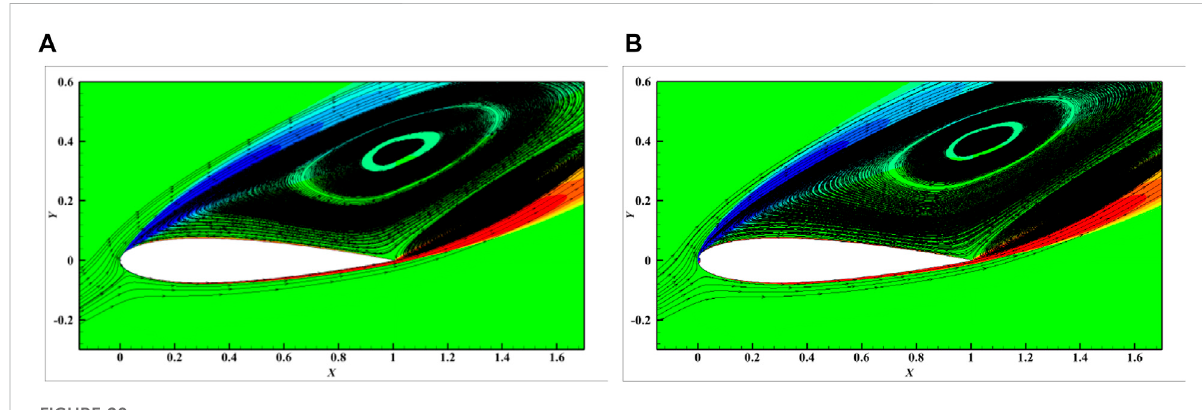
FIGURE 20 Surface streamlineand vorticity oftheSemi-circularerosionon theleading edgeoftheNACA0015 airfoilat22 ° angle ofattack.( (A) : h 1 =0.3% c ; (B) : h 1 = 1% c